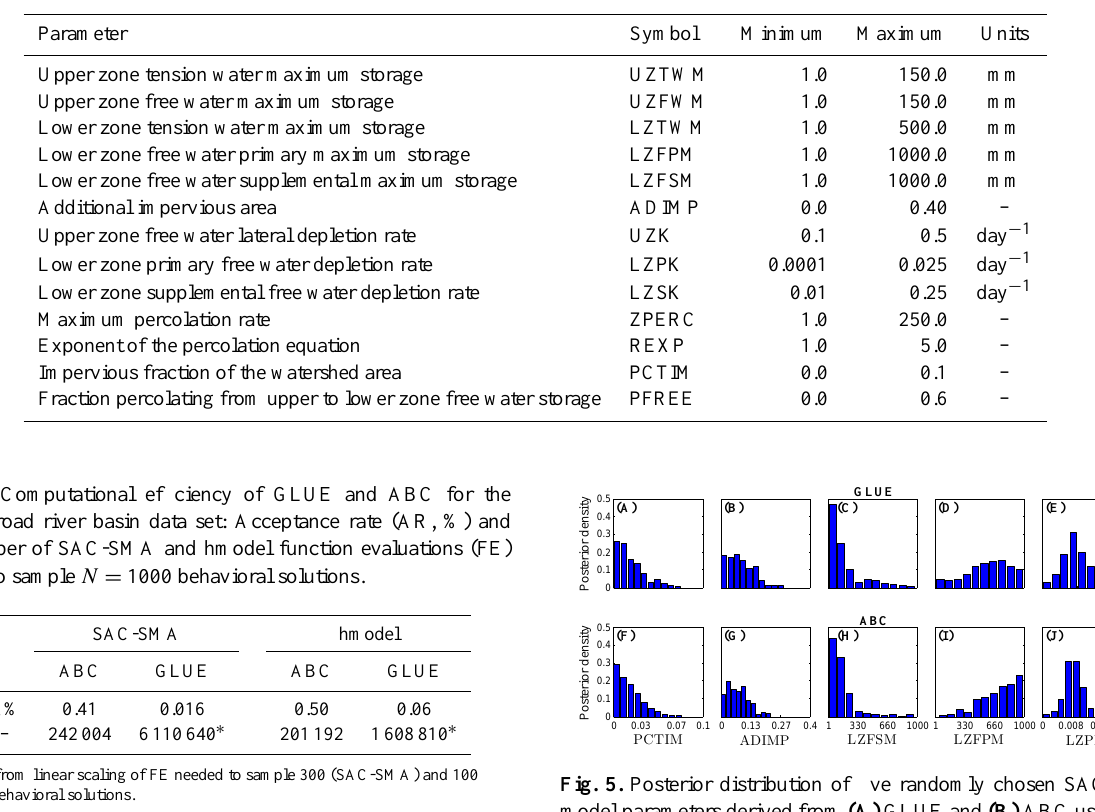
ability) and the bottom panel shows the corresponding coun- terparts for ABC. To limit the computational burden, GLUE was terminated after 300 behavioral solutions were